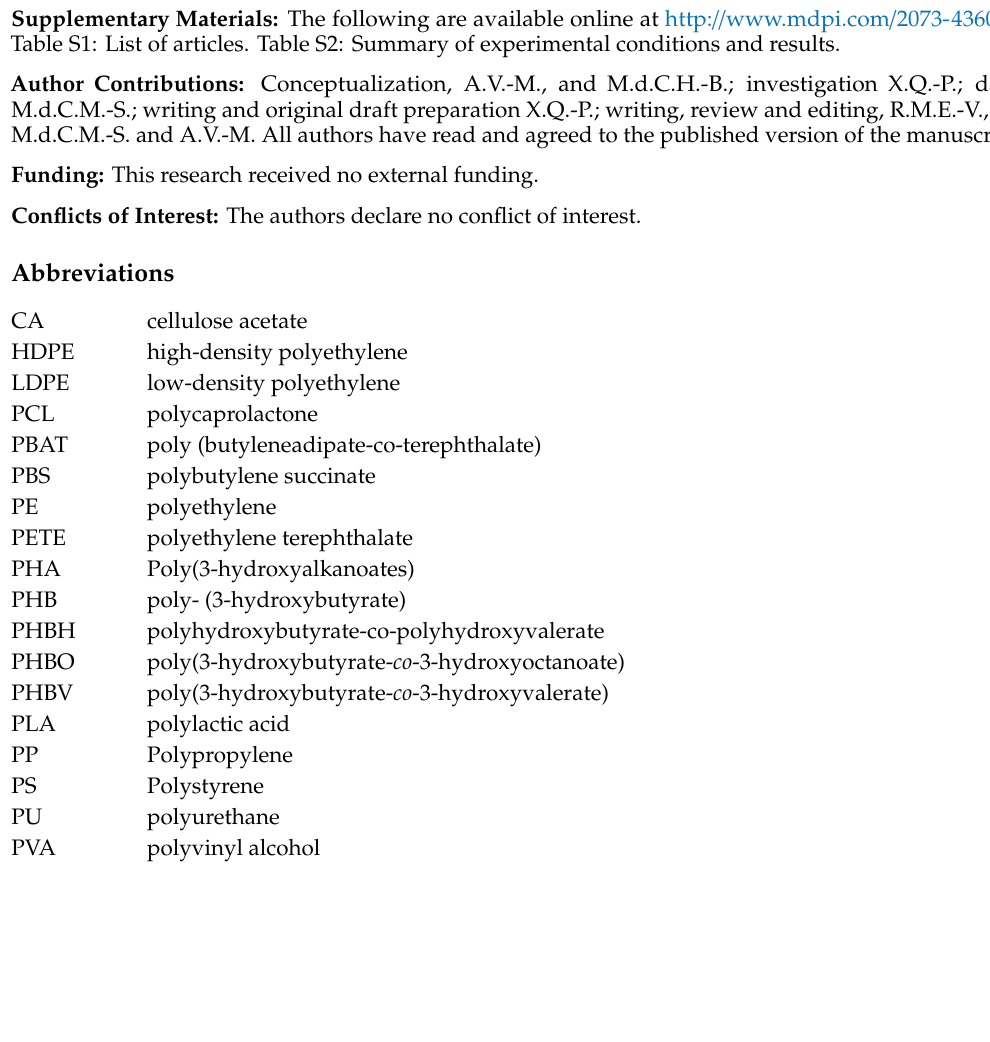
Table S1: List of articles. Table S2: Summary of experimental conditions and